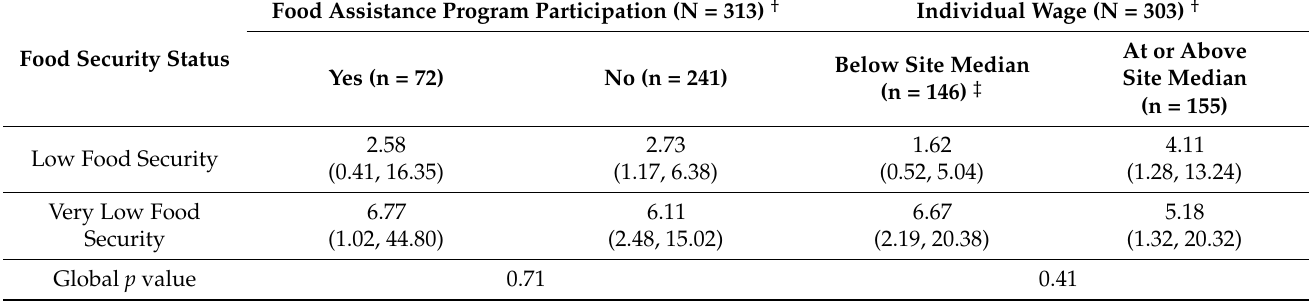
Table 4. Logistic regression estimates (odds ratios) for the association between food insecurity and depression among a cohort of early care and education (ECE) providers in Washington and Texas, stratified by food assistance program participation and wage